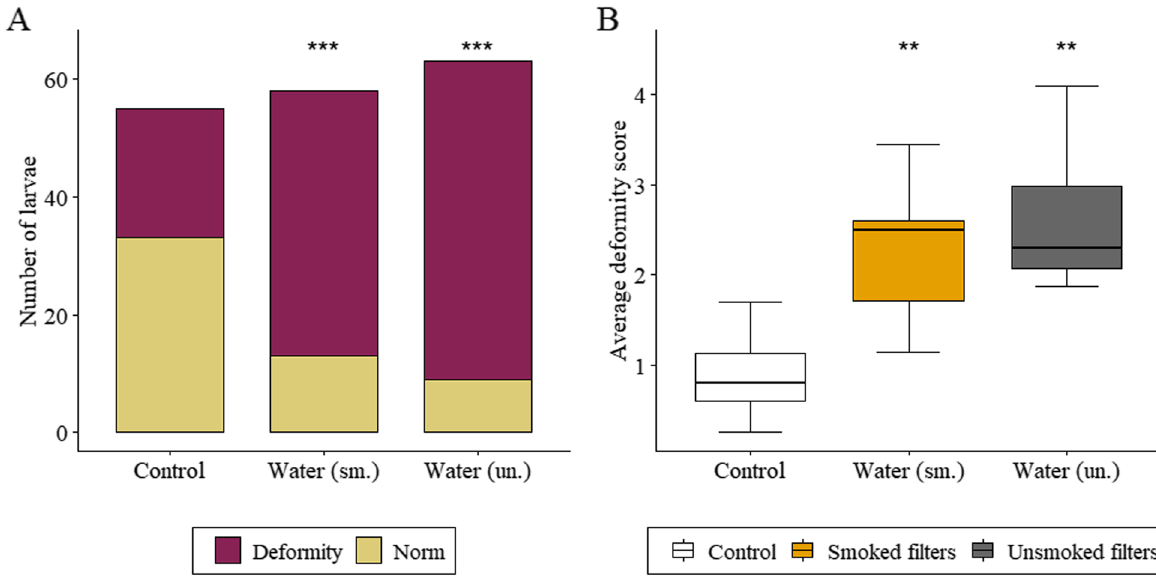
Fig. 7 Teratogenicity of cigarette filter leachates following the 7-day exposure. Occurrence of mouthpart deformities ( A ) is shown as the proportion of larvae presenting mouthpart deformities in the control and water treatment groups ( a 3, N 176). Mouthpart deformity scores ( B ) are = = shown as mean deformity scores per replicate ( n 7) for the control and water treatment groups ( a 3, N 21). The boxes display the 25%- and = = = 75%-quartile, dark lines the median, and the whiskers extend to one and a half times the interquartile range. Results shown are from exposures via water, using smoked (sm.) or unsmoked (un.) filters. The asterisks indicate evidence for increased frequency ( A ) and severity ( B ) of mouthpart deformities in the treatment groups compared to the control with p < 0.01 for (**) and p < 0.001 for